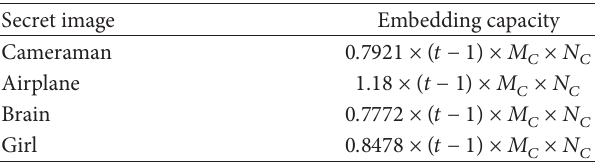
Table 6: The embedding capacity.